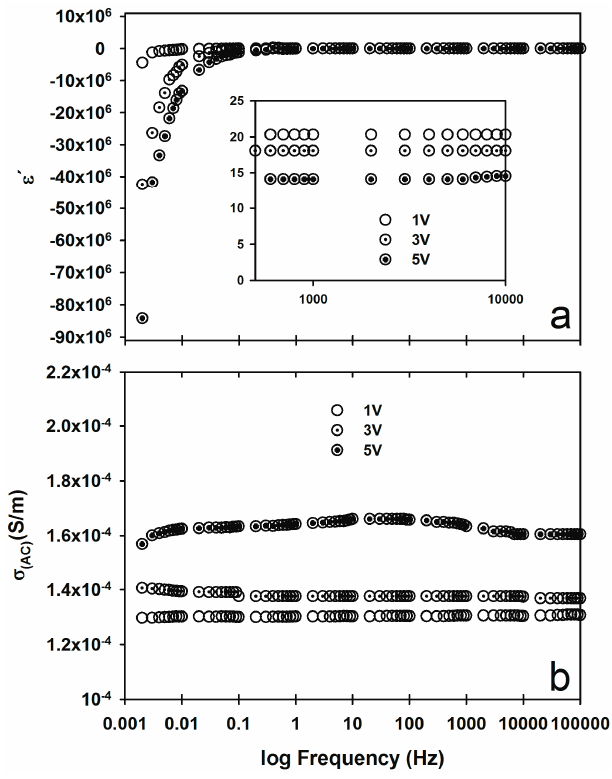
Figure 4. Electrical properties of iPP MFI=1200 /MWCNT obtained by the PT fabrication method, ( a ) ε′ and ( b ) σ (AC) .